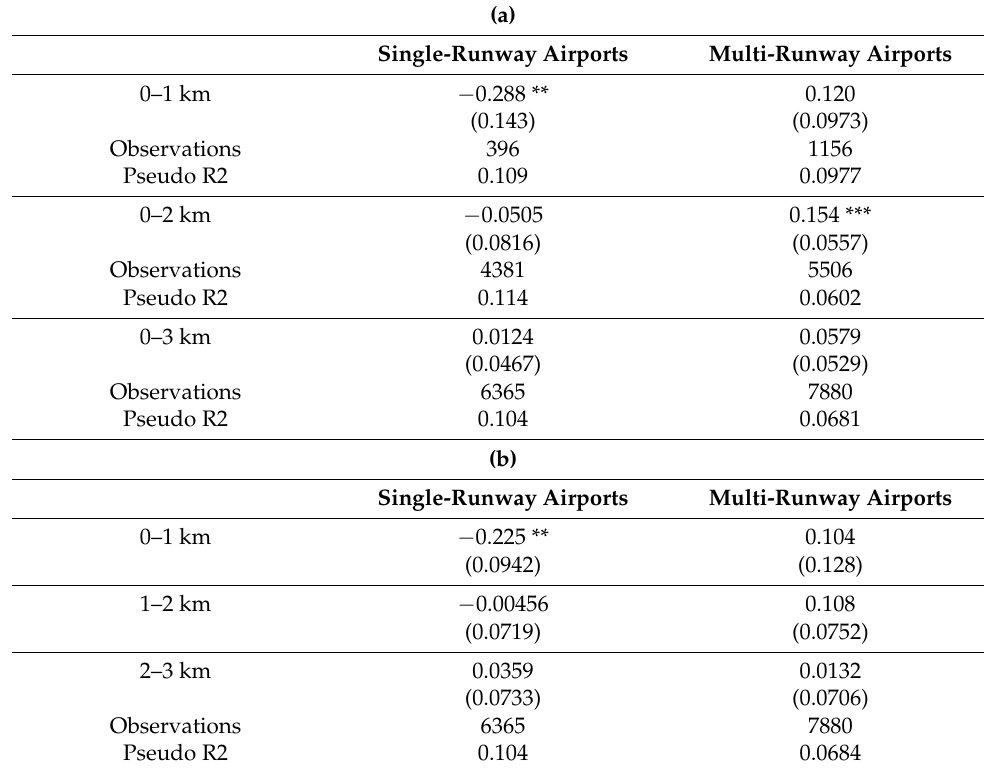
Table 3. ( a ) Key coefficient results from separate regressions with varying treatment cutoffs: Associa- tion between proximity to TFMSC airports with age 65+ cardiovascular mortality. ( b ) Key coefficient results from single regression with 3 km treatment cutoff: Association between proximity to TFMSC airports with age 65+ cardiovascular